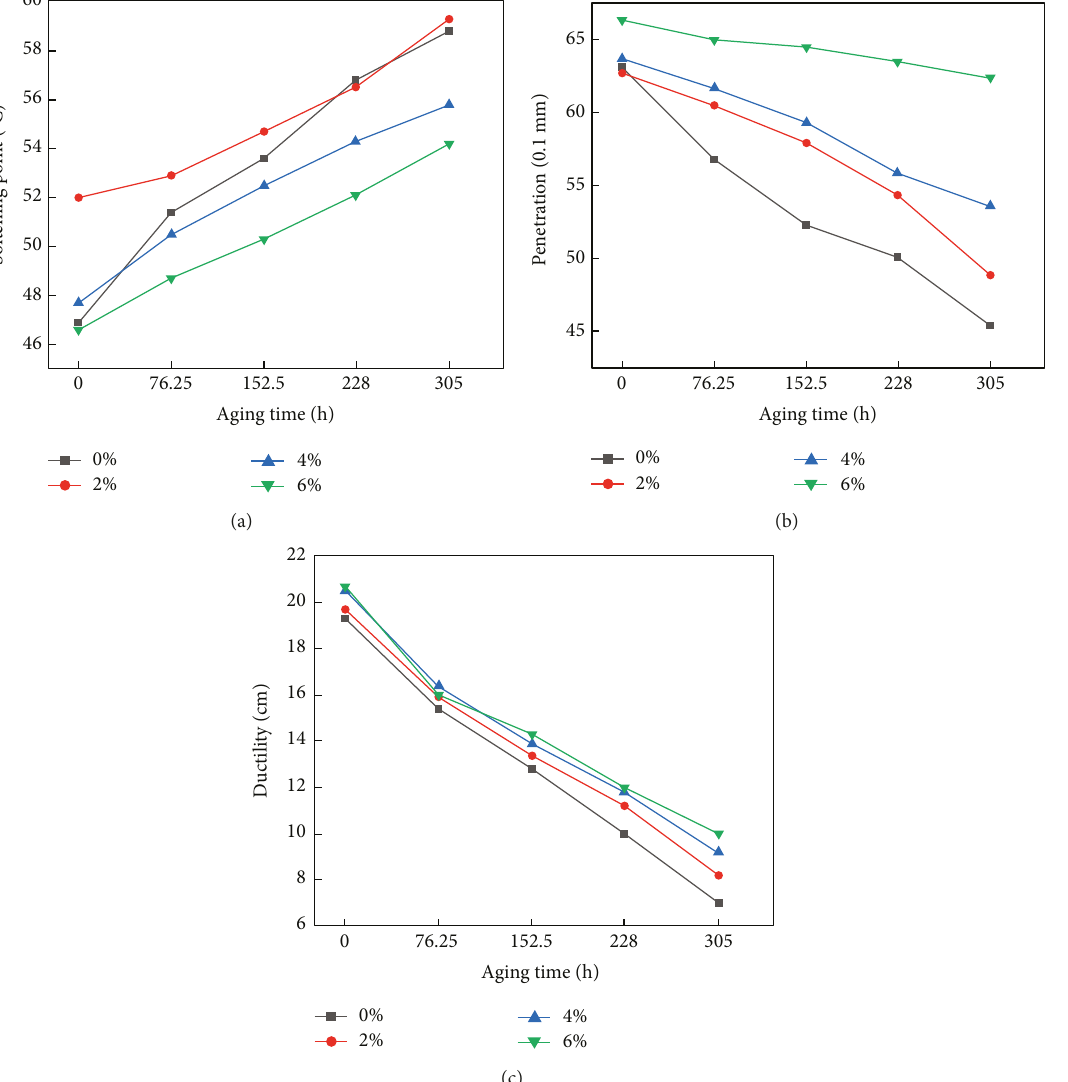
Figure 4: Conventional test results under different UV aging times. (a) Softening point. (b) Penetration. (c)